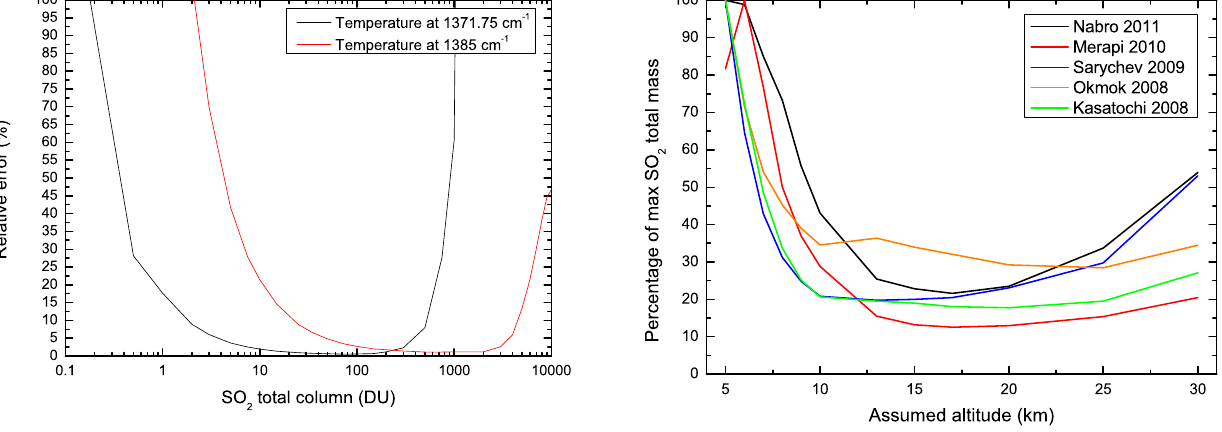
Fig. 7. Effect of the assumed altitude on retrieved abundances; il- lustrated for different